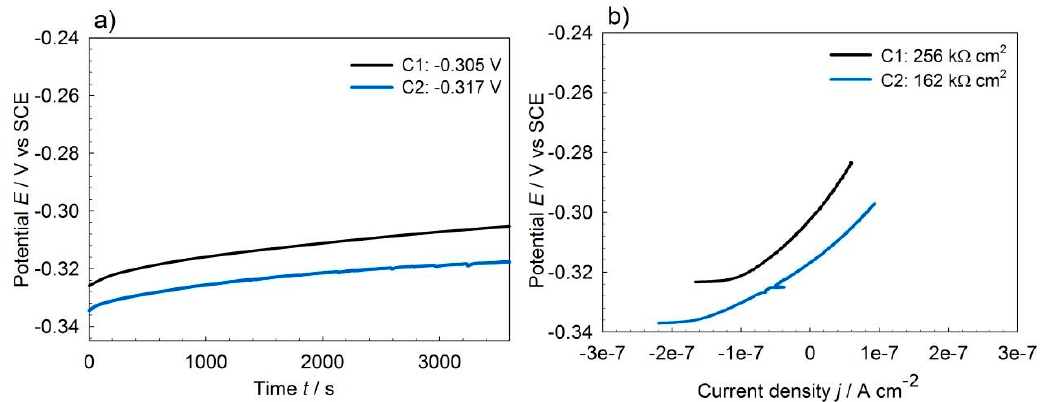
Figure 9. ( a ) Corrosion potential measurements; ( b ) linear polarization measurements; for series C steels in a Na-tetraborate buffer, pH = 10, at a scan rate of 0.1 mV/s.